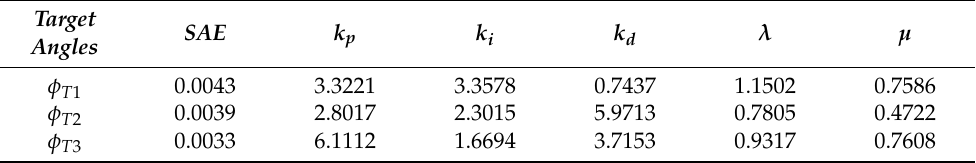
Table 3. Stabilizing FOPID controller designs that are obtained for φ T 1 , φ T 2 and φ T 3